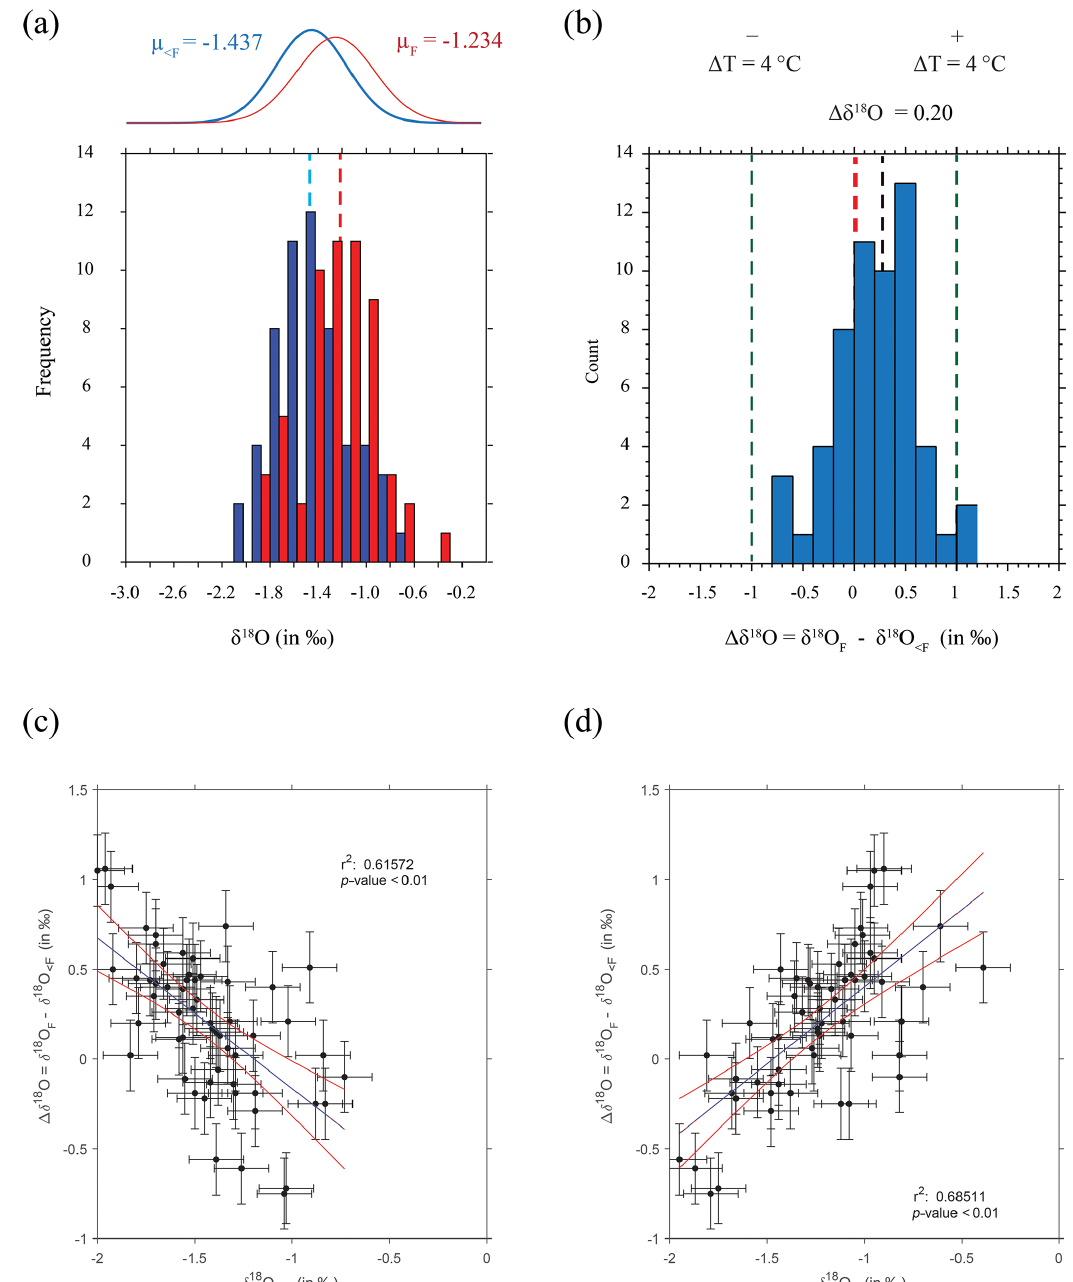
Figure 5. Final chamber vs. rest of shell δ 18 O. (a) Raw δ 18 O values of rest of shell (blue) and final chamber (red) plotted as a histogram, vertical bars represent sample means. Fitted normal distributions for rest of shell ( µ < F ; blue) and final chamber ( µF red), with mean average values are also indicated. Histogram bins are in 0.25‰ bin intervals, the equivalent of ∼ 1 ◦ C depending on whether the data are on the high or low end of the scale. (b) Histogram of the same specimen difference in δ 18 O ( ≡ (cid:49)δ 18 O) between < F and F . Vertical green lines at (cid:49)δ 18 O of ± 1‰ represent a ∼ 4 ◦ C temperature variation, a vertical red line denotes no difference ( (cid:49)δ 18 O = 0). The average (cid:49)δ 18 O ( µ = 0 . 203) is shown as a black vertical line. (c, d) Scatter plot of the same data plotted as either the (c) < F remaining of the shell and (d) the F chamber δ 18 O vs. (cid:49)δ 18 O. Vertical error bars represent the square root of the sum of the error’s squared the horizontal a single machine error. Blue line is the linear regression and the blue a confidence interval on the regression. All values in per mil (‰) on the V-PDB